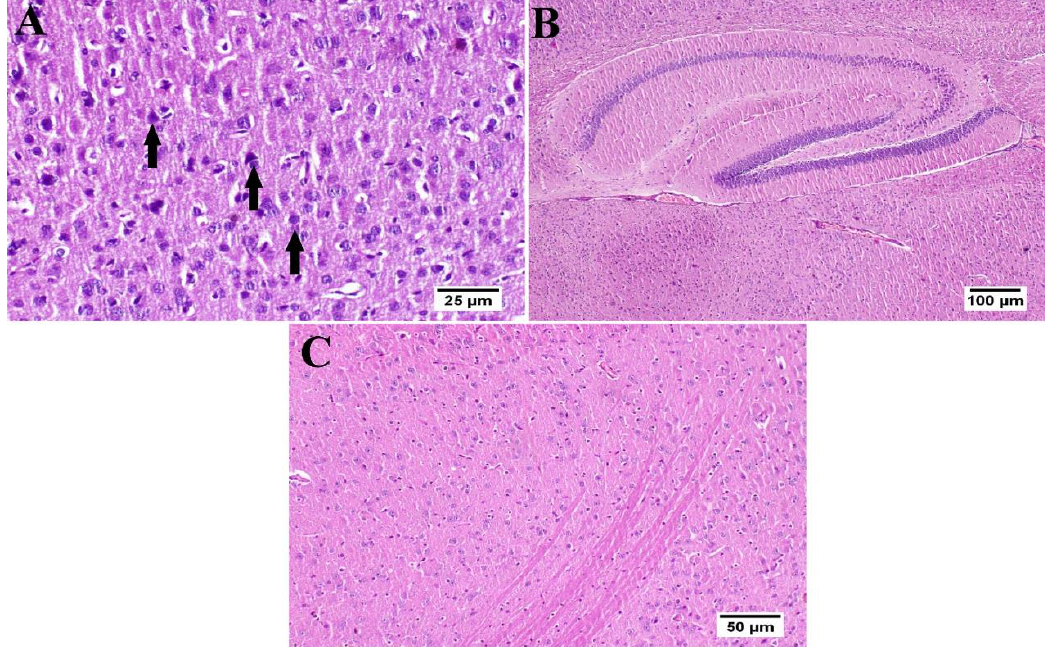
Figure 10. Effect of donepezil on STZ-injected mice brain histopathological examination (n = 3) (H&E). Animals treated with donepezil in group V showed ( A ) few degenerated neurons and neuronophagia (arrows) in the cerebral cortex. ( B ) The hippocampus and ( C ) striatum showed apparently normal neurons on all examined sites.